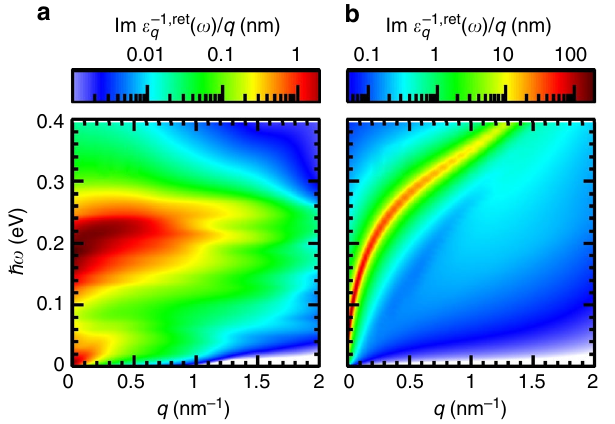
Fig. 6 Different screening properties of excitons and quasi-free carriers. Plasmon spectral function given by the imaginary part of the inverse dielectric function, including the 2- d -Coulomb singularity. In the calculation, the contributions due to dynamical plasma and excitonic screening are included. The results are depicted for momenta along the contour Γ - K in WS 2 on SiO 2 substrate at T = 300 K. A quasi-particle broadening of 10 meV is used. The carrier densities are ( a ) n free = 2.7 × 10 10 cm − 2 , n X = 3.1 × 10 12 cm − 2 and ( b ) n free = 1.8 × 10 13 cm − 2 , n X = 0 corresponding to points on the ionization equilibrium curve in Fig. 2 in the exciton-dominated and the plasma-dominated regime, respectively